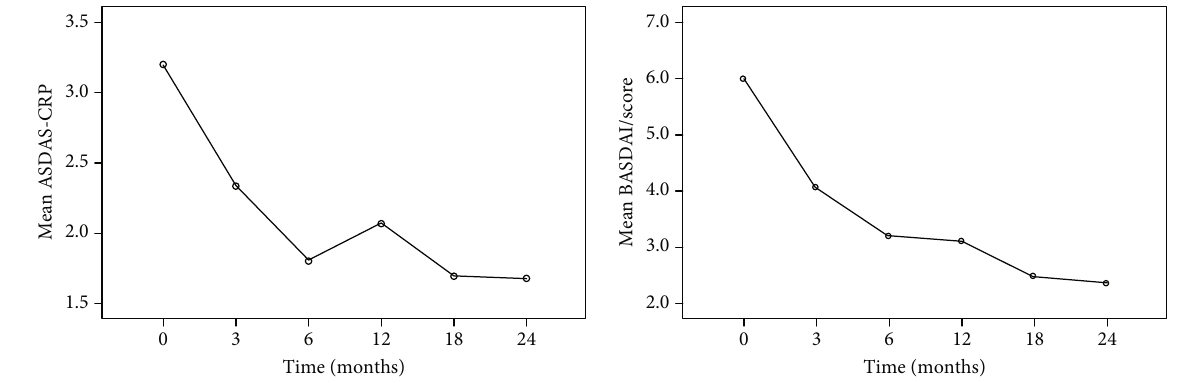
Figure 1: Variations of ASDAS and BASDAI indexes mean values in our cohort over the study period.